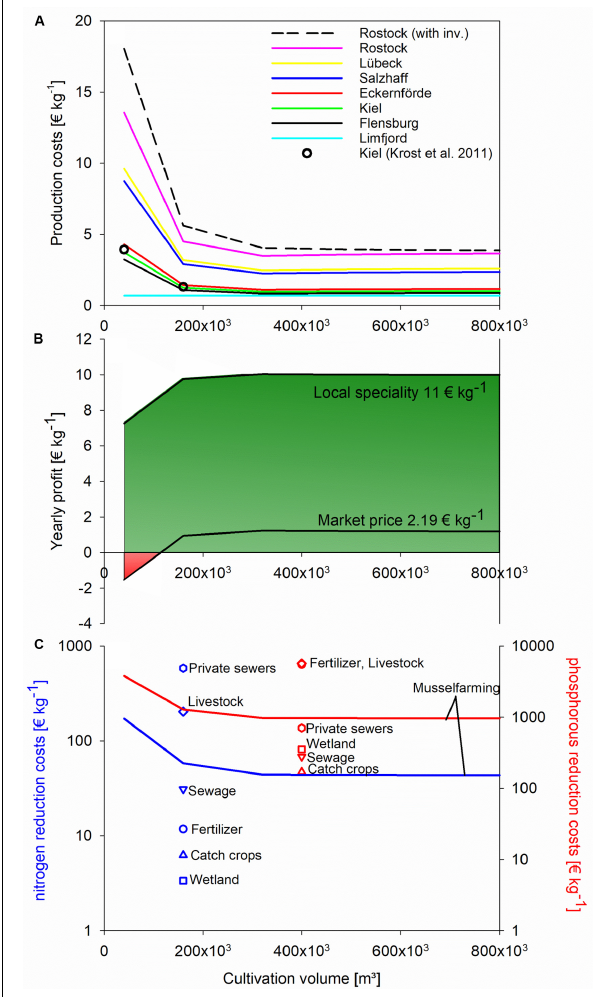
FIGURE 5 | (A) Yearly operational costs of mussel production for human consumption west of Rostock, excluding investment costs (with investment costs for Rostock as comparison), inclusion of cost data by Krost et al. (2011) (black circle) and inclusion of minimal reported production costs of 0.7 € kg - 1 (Limfjord production); (B) profitability for mussel farming in Kiel Fjord, if sold for human consumption, following two market price scenarios (neglecting upfront investment costs); (C) costs for phosphorus (red) and nitrogen (blue) removal: comparing mussel farming (example of Kiel Fjord, neglecting upfront investment costs) with other measures after Gren et al.